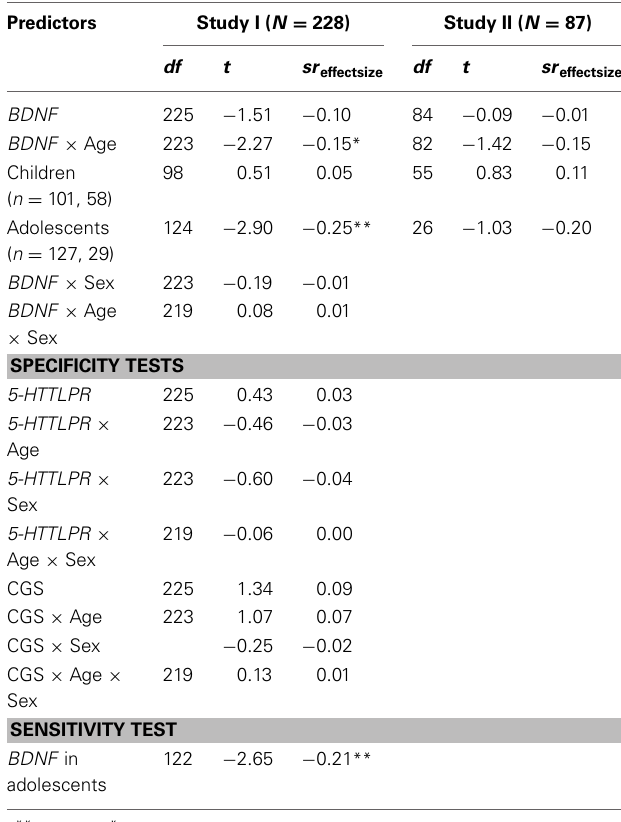
Table 2 | Genetic associations with brooding rumination: multiple linear regressions test whether BDNF (Val/Val genotype vs. Met allele carriers) directly in moderation with age or gender, predicts youths’ tendency to